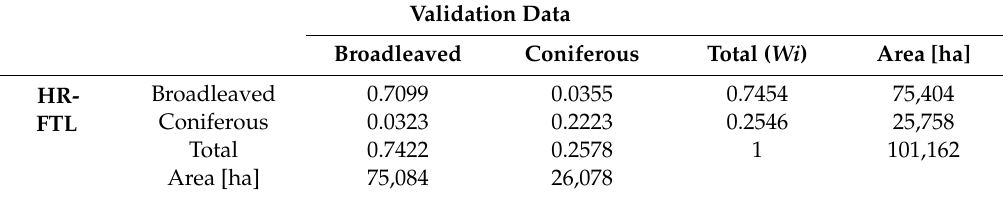
Table 12. Error matrices of estimated proportions of area for the HR-FTL in Luxembourg.